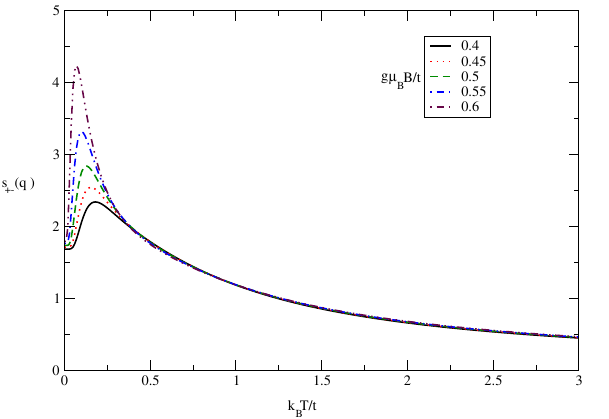
( q 0 , T ) of undoped Germanene layer versus +−